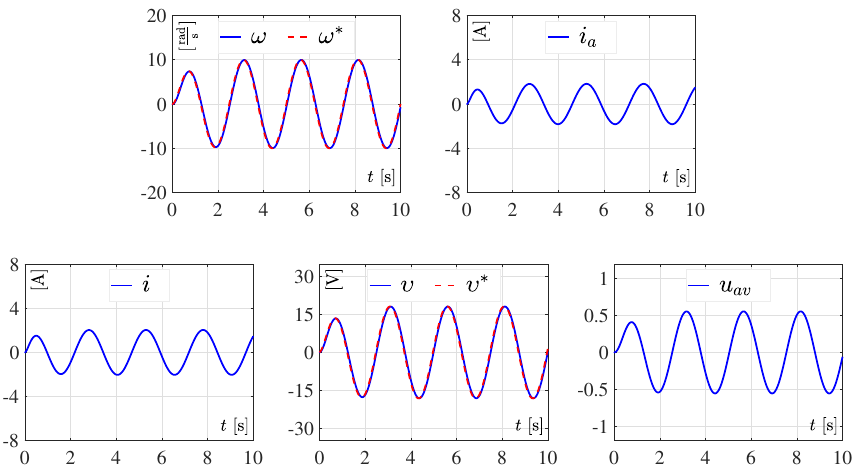
Figure 10. Simulation response of the system in closed-loop for the third desired angular veloc- ity ω ∗